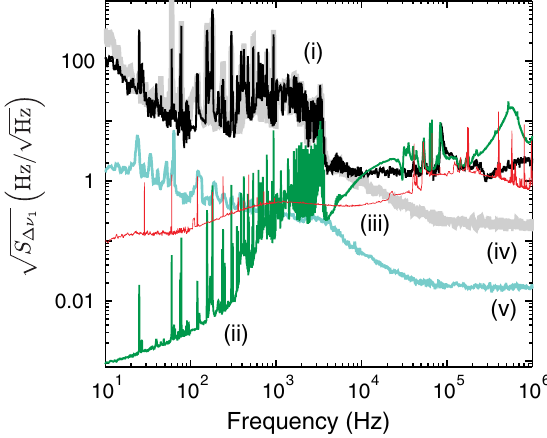
FIG. 5. Spectrum of line-spacing fluctuations S . The (cid:1) (cid:2) 1 black (i) and green (ii) lines show the free-running and stabilized line-spacing spectral density, respectively. The broad resonance at 600 kHz in the green line coincides with a mechanical resonance of the fused-quartz rod, which we speculate is weakly excited via the PZT. The red (iii) line indicates the contribution . The gray (iv) and blue (v) lines show the from reference f 1 predicted contributions from pump frequency and intensity noise,